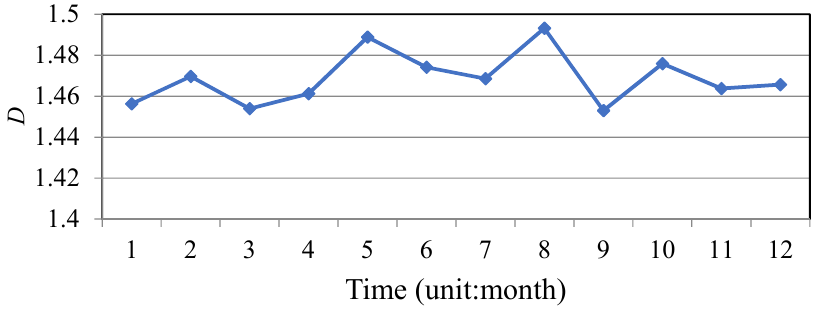
Figure 3. Fractal dimension of monthly wind speed.